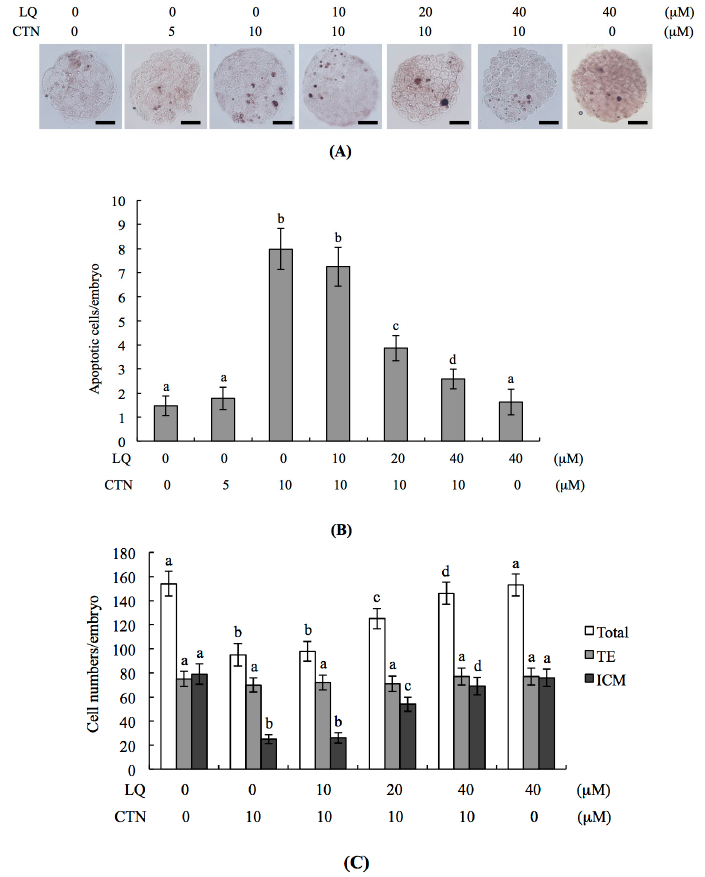
Figure 1. Effects of liquiritigenin (LQ) on citrinin (CTN)-induced apoptosis in blastocysts. Mouse blastocysts were pretreated with LQ at the indicated concentrations for 1 h, followed by treatment with or without CTN (5–10 μ M) at the indicated concentrations for 24 h. Medium containing 0.5% dimethyl sulfoxide (DMSO) was used as the control (vehicle group). ( A ) Cell apoptosis in blastocysts was analyzed via terminal deoxynucleotidyl transferase dUTP nick end labeling (TUNEL) staining. TUNEL-positive cells (black) were visualized under a light microscope; ( B ) The mean number of apoptotic (TUNEL-positive) cells per blastocyst was counted; ( C ) Cell numbers of blastocysts were analyzed via differential staining and the number of inner cell mass (ICM) and trophectoderm (TE) cells per blastocyst calculated. Data were obtained from at least 240 blastocysts per group. Values are presented as means ± SD (standard deviation) of five determinations. Different symbols indicate significant differences at p < 0.05. The scale bar is 20 μ m.